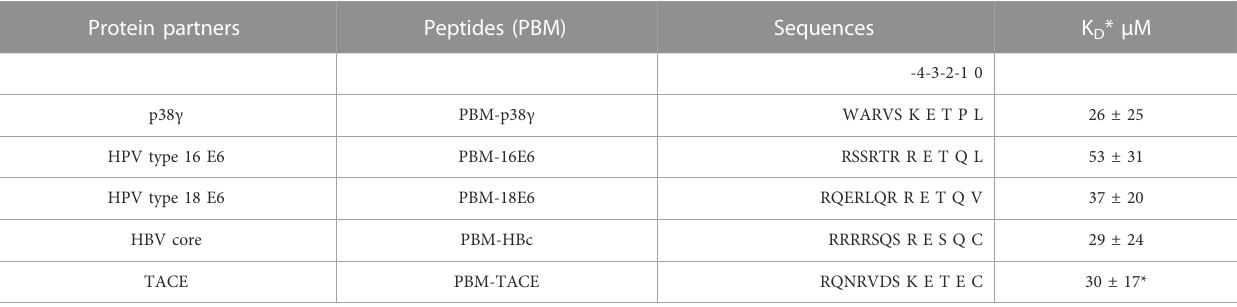
TABLE 1 Af fi nities and peptide sequences of PBMs of cellular and viral partners of PTPN3-PDZ. Protein